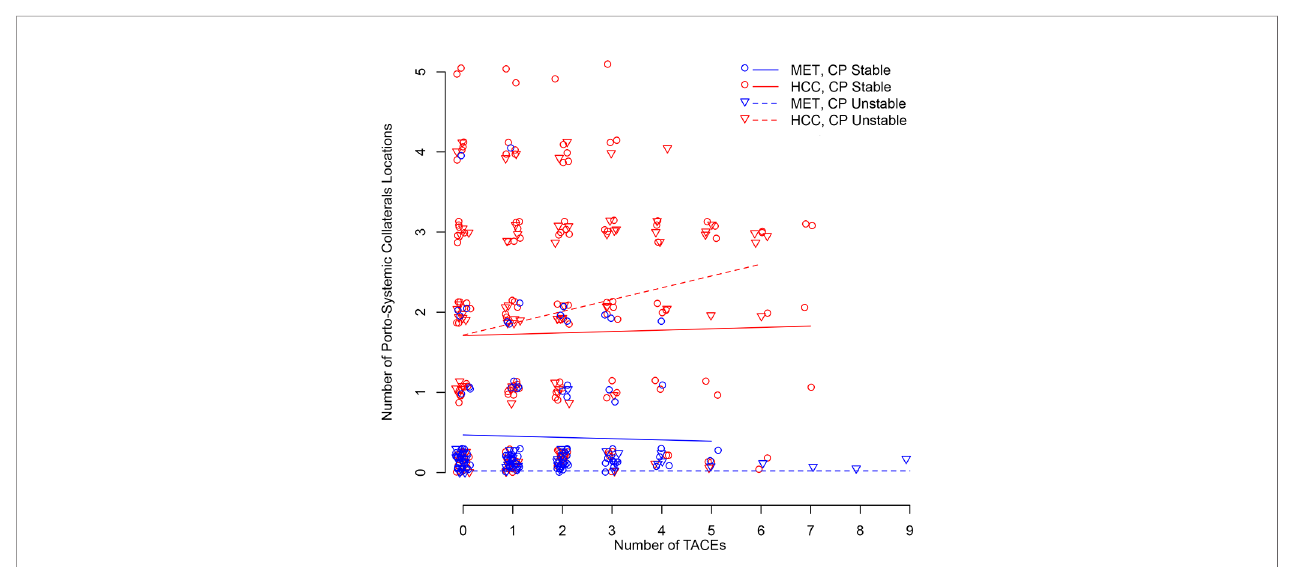
FIGURE 4 | Scatter plot illustrating longitudinal changes over time in the number of portosystemic collaterals locations according to the number of TACEs and strati fi ed by Child-Pugh (CP) stability (line = stable, dotted line = unstable) and metastatic (MET)/HCC groups. Each small shape ( D or O) represents a patient ’ s presence at a TACE. Shapes are jittered for visualization purposes to avoid cluttering on top of each other. The linear time model in the log(Probability)/(1-log (Probability)) scale shows as a curve (nonlinear) model in the Probability